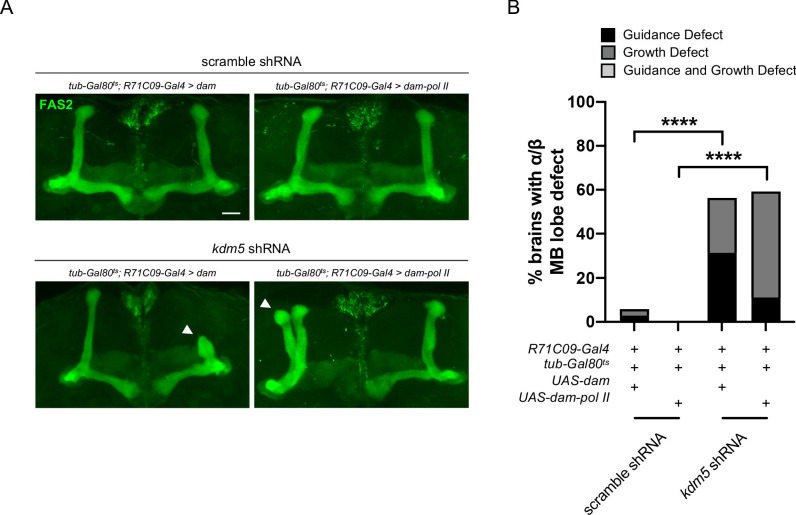
Adults expressing R71C09-Gal4-driven kdm5 shRNA in tandem with targeted DamID (TaDa) genetic elements present with significant mushroom body morphological defects.(A) Representative α/β lobe Z projections of adult R71C09 > kdm5 shRNA animals expressing TaDa genetic elements and their respective controls. The antibody anti-fasciclin 2 is used to visualize α/β lobes. Arrowheads indicate guidance defects. Scale bar represents 20 μm. (B) Quantification of α/β lobe Z projections of adult R71C09 > kdm5 shRNA animals expressing TaDa genetic elements and their respective controls. n = 16–34 (mean n = 28). ****p<0.0001 (chi-square test with Bonferroni correction).